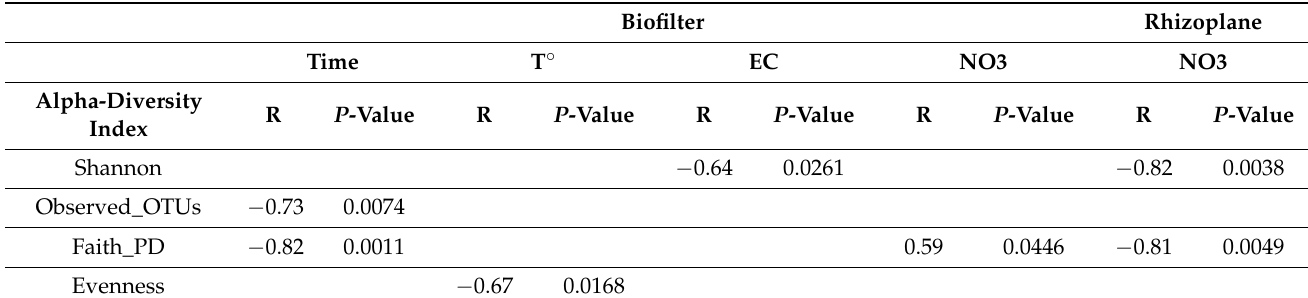
Table 2. Spearman correlations between alpha-diversity indices and water and system parameters when significant ( p -value < 0.05). The correlation coefficients are available in the ‘r’ column with the corresponding p